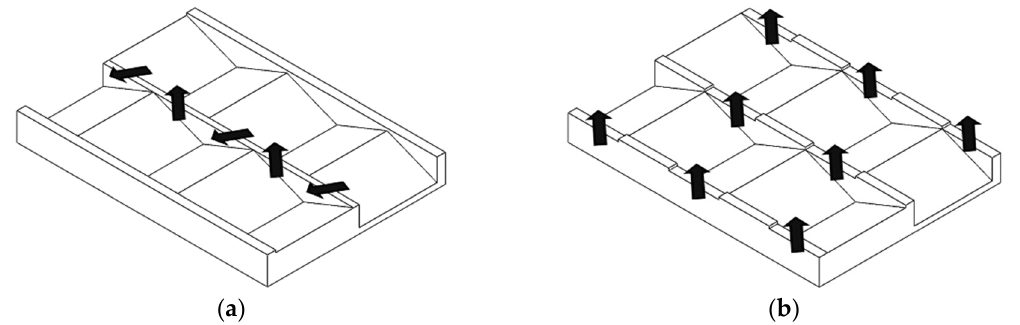
Figure 1. Unwound channel of a double-wave screw ( a ) and energy-transfer screw ( b ).